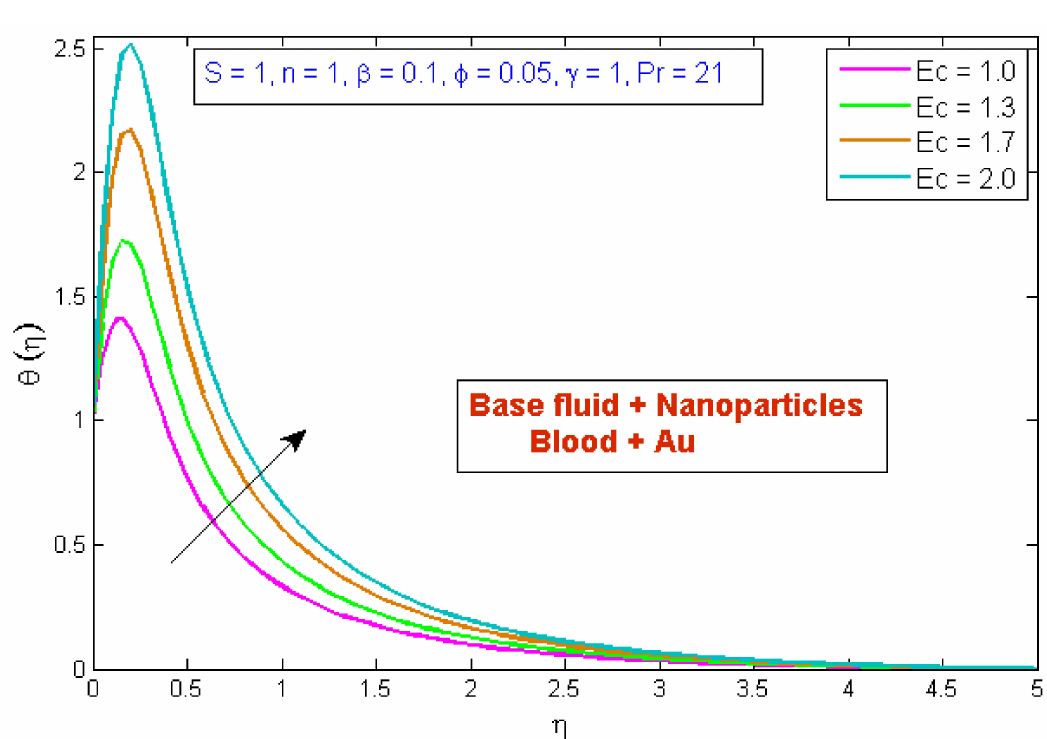
Figure 11. Modification of θ ( η ) versus Ec .